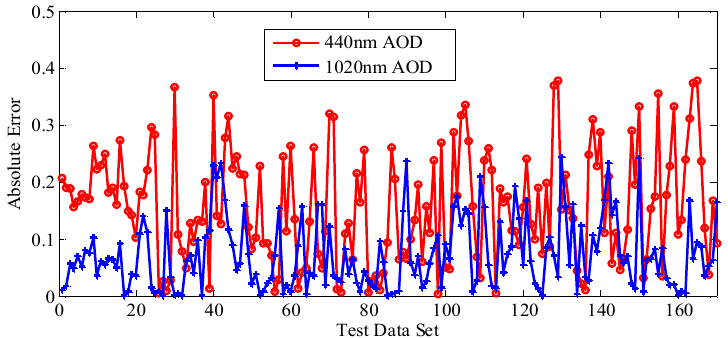
Figure 5. Estimation results of support vector machine (SVM) models on the training data set.